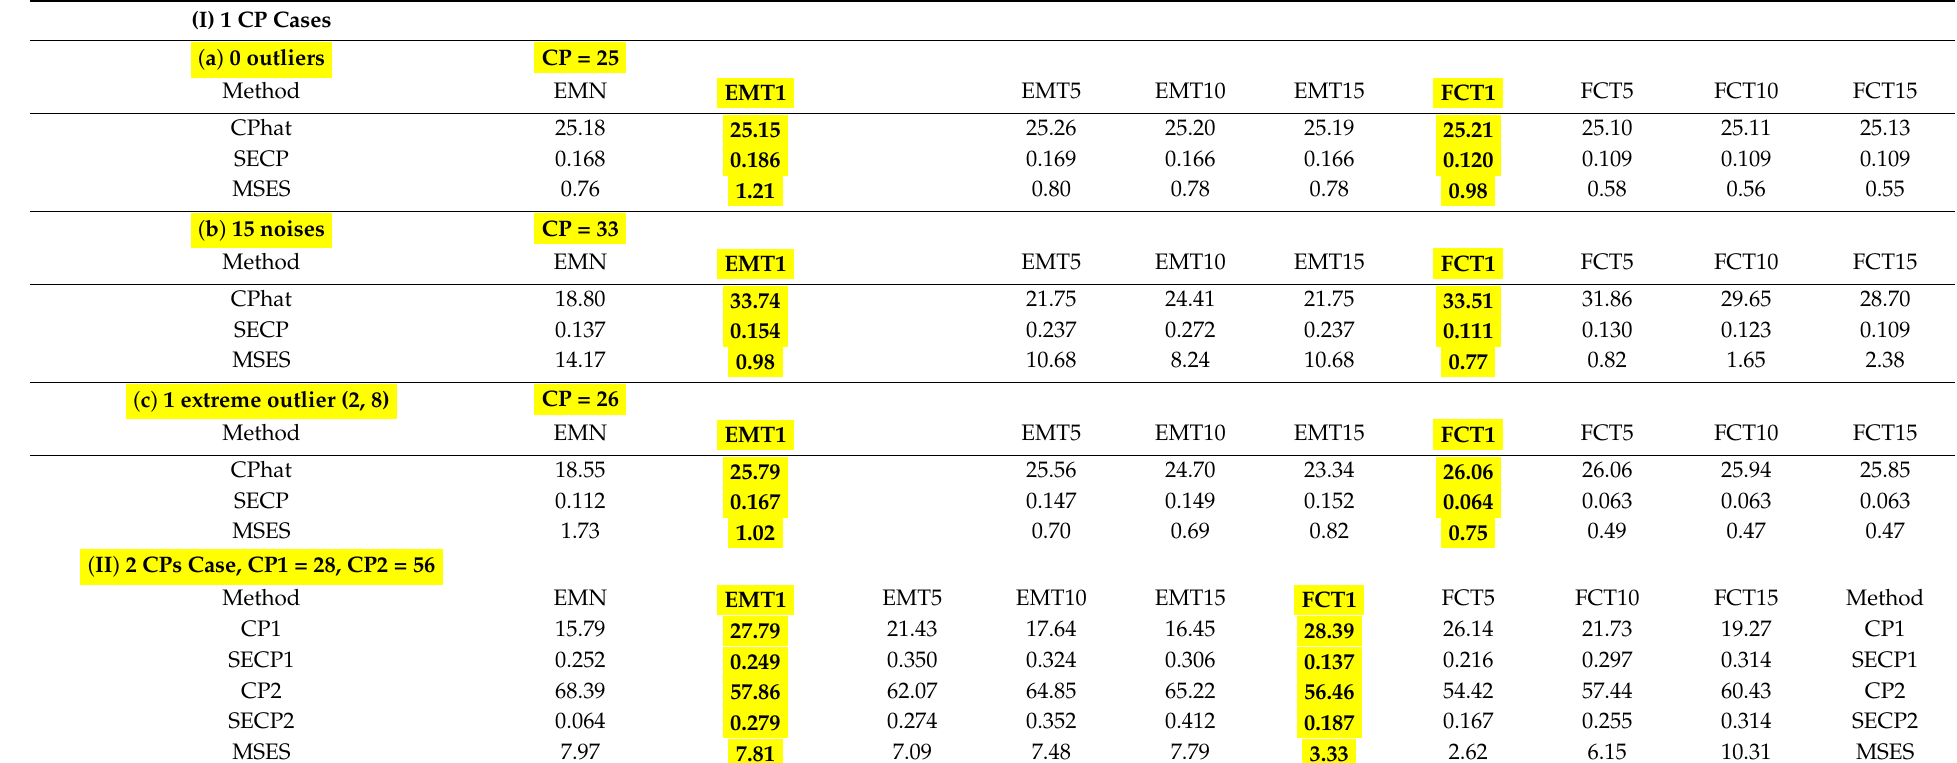
Table 1. The performance of EMT and FCT with different degrees of